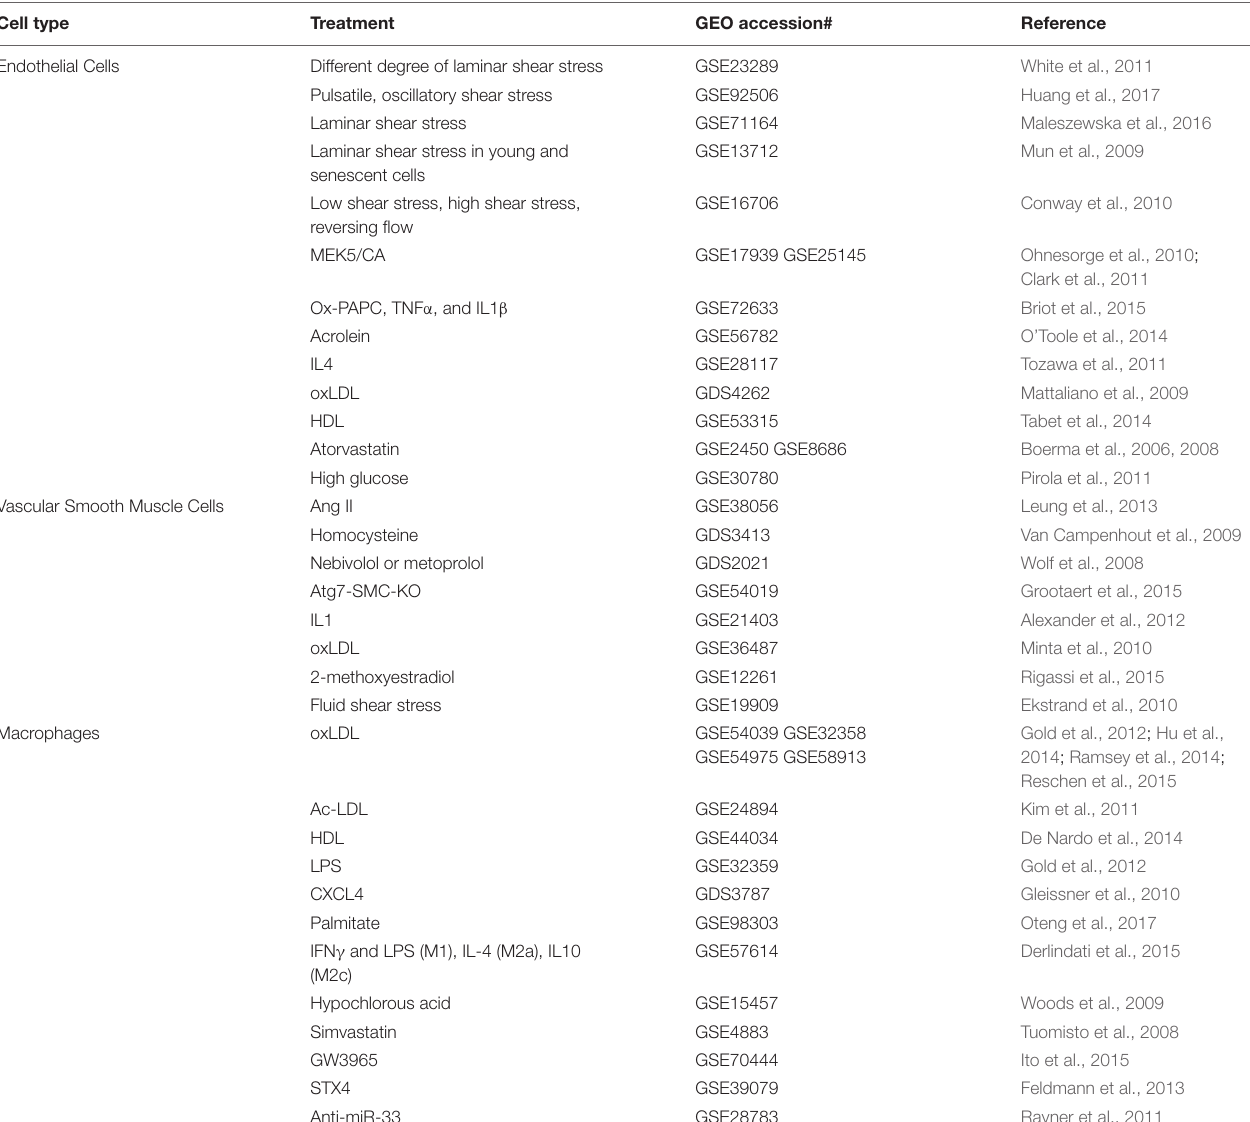
TABLE 5 | Gene profiling studies in cultured vascular